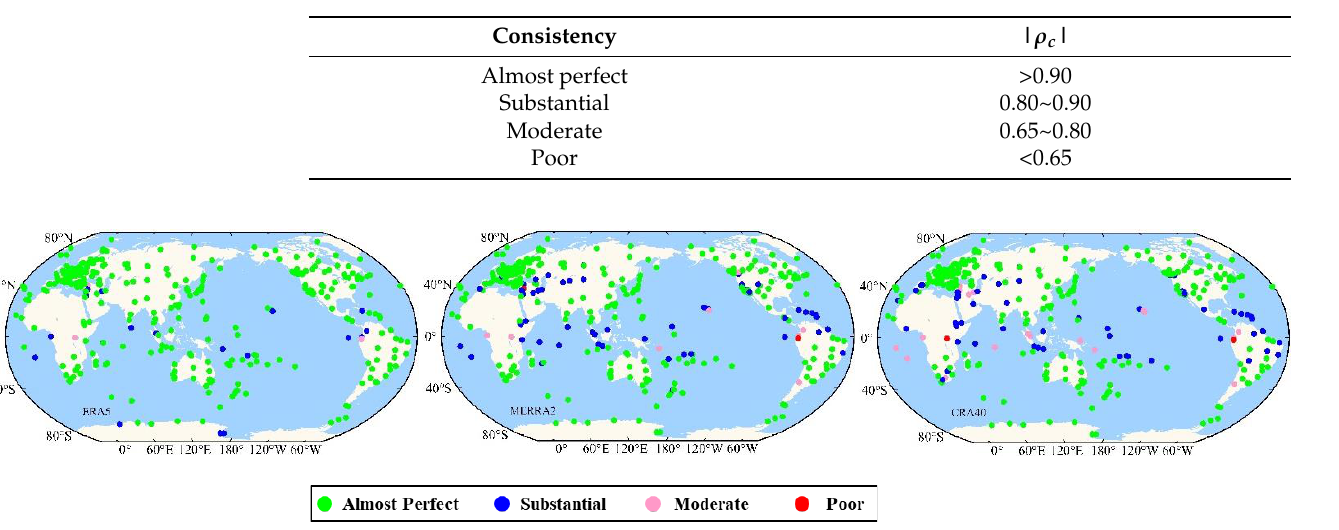
Figure 5. Global consistency distribution of the three inverted ZTDs. Table 3. Statistics on the number of stations for each type of consistency from the three ZTD